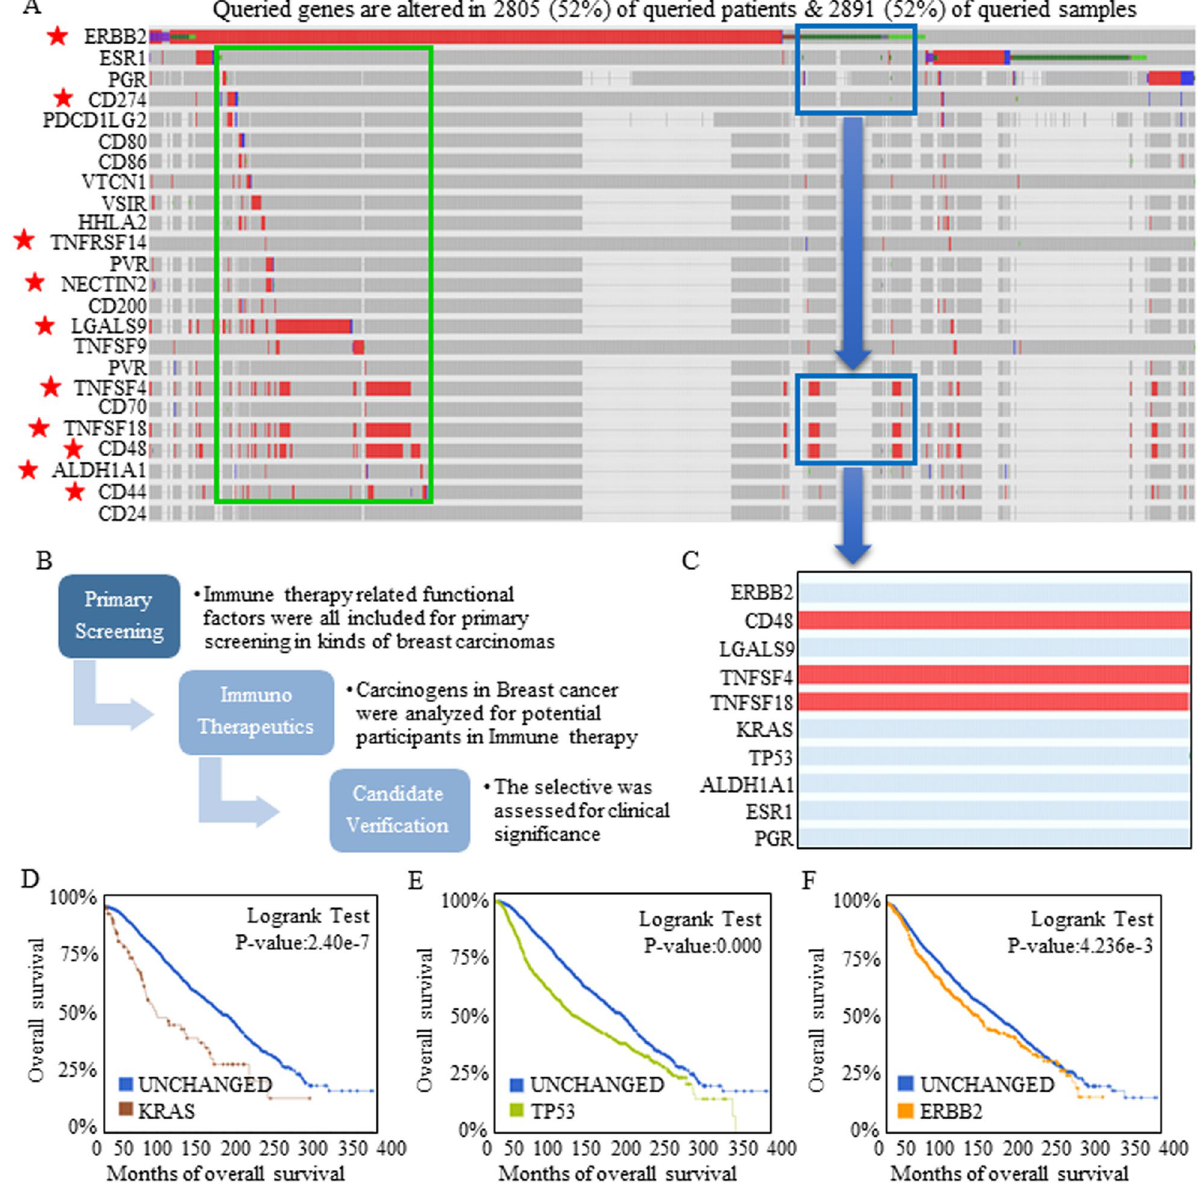
Figure 2. Selection of the most representative immune checkpoint molecules targeted by blockade. Expression signatures and correlations were studied using cBioPortal and GEPIA2. ( A ) Expression heat-map showing the expression of each candidate in a red bar, and the most representative genes are labeled with a red star. The red bars indicate actual data points, and the gray bars indicate that no specific data were available. ( B ) The analysis flowchart is shown. ( C ) Nearly all the immunotherapeutic targets showed expanded expression intervals referring to ESR1 and PGR, and TNFSF4, TNFSF18, and CD48 showed increased expression in breast carcinomas without ERBB2, ESR1, and PGR expression. Amplification or mutation of KRAS ( D ), TP53 ( E ), or ERBB2 ( F ) indicated worse predicted